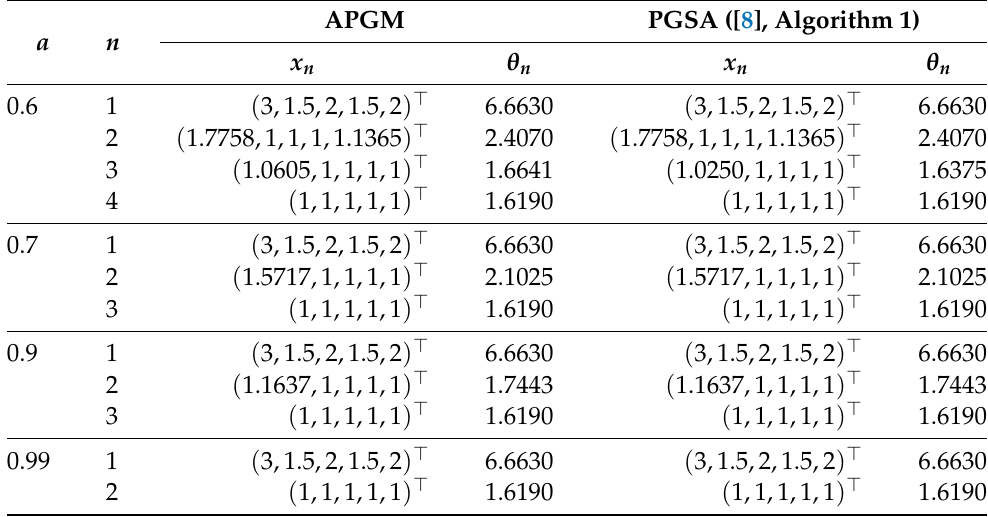
Table 1. The behavior of the iterate x n and function value θ n when performed by APGM and PGSA with various values for a